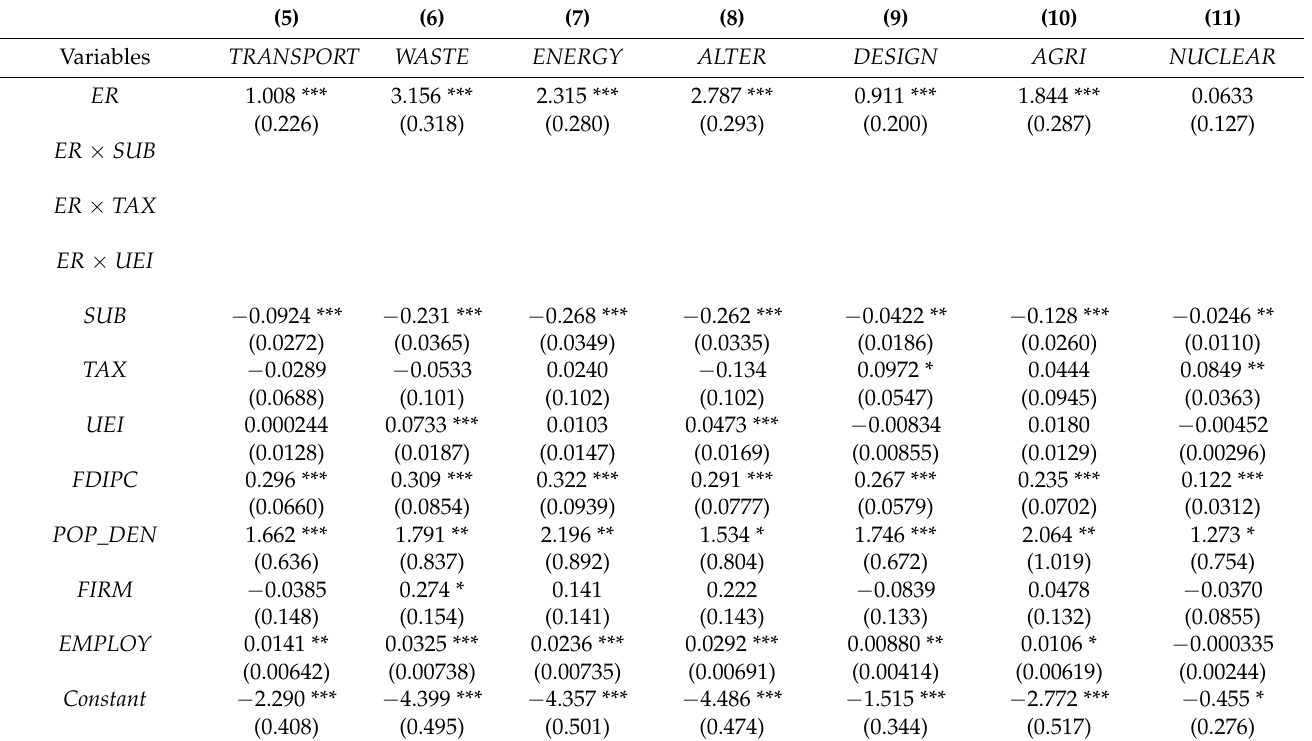
Table 3. Direct effects of government interventions across fields of